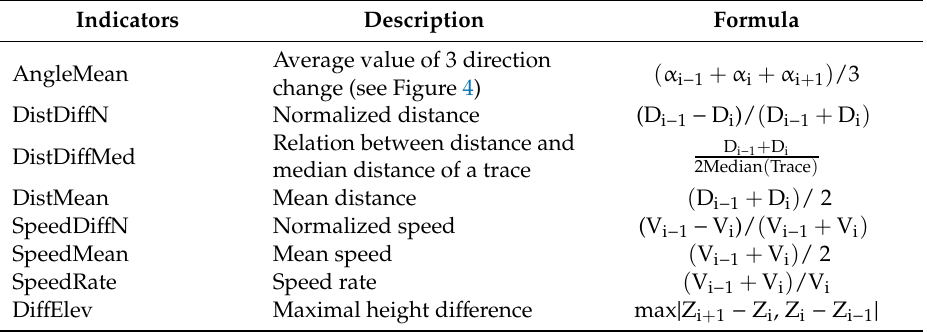
Table 1. Definition of intrinsic indicators.